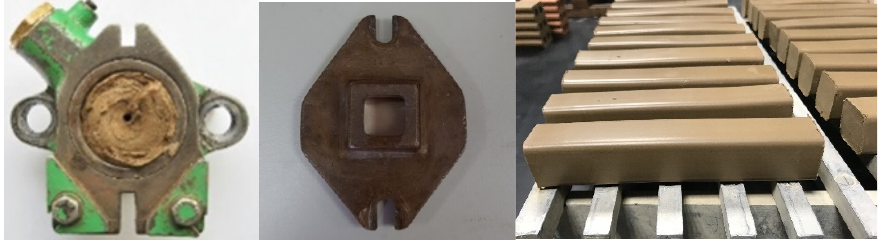
Figure 4. The vacuumed mixture in the extruder, the sample mouth, and the constructed pieces.